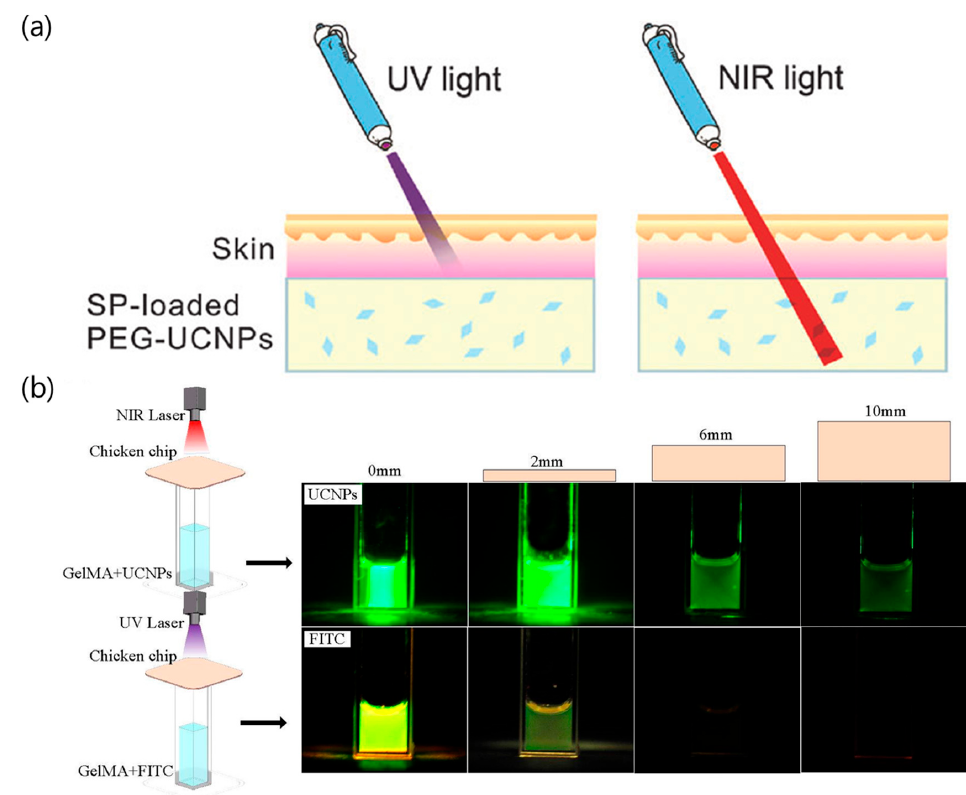
Figure 2. ( a ) Illustration of the penetration depths for UV and NIR light [55]. ( b ) Photographs of tissue penetration for NIR and UV light. Slices of chicken breast with various thicknesses (2 mm–10 mm) were placed between the laser source and the glass cuvette containing the UCNP-labeled hydrogel